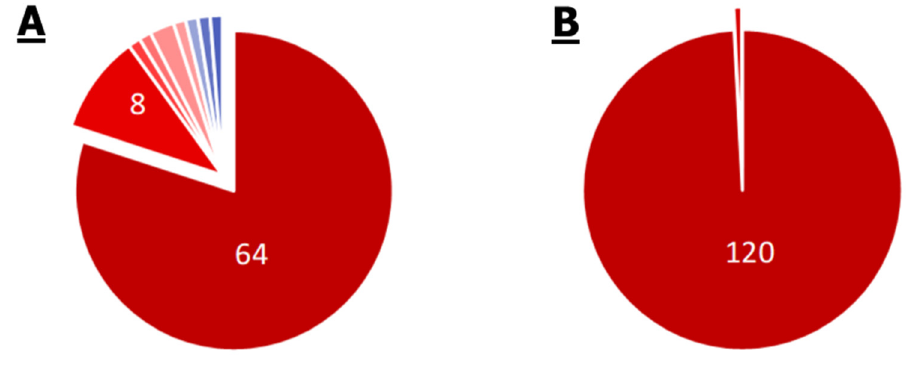
Figure 4. Pie chart of the proportion of annotations in the 21 genomes of P. aeruginosa strains. Numbers depict annotations with equal frequency. Frequency—from 0.15 to 1—is presented in the color of slices on the scale from blue to red for distribution of modules ( A ) and pathways ( B ). Small slices without numbers correspond to the sole annotation. Among 64 core modules, there are two multidrug resistance modules: efflux pumps MexCD-OprJ and MexJK-OprM. Among eight modules with frequency equal to 0.95, there are efflux pump MexAB-OprM and imipenem resistance modules, the rest are metabolic modules. Efflux pump MexEF-OprN and MexPQ-OpmE are present in 81% of genomes, efflux pump MexXY-OprM in 76%, and the carbapenem resistance module in 14%. The rest of the modules are metabolic. One hundred and twenty out of 121 pathways are present in every genome and one pathway has frequency of 0.95.